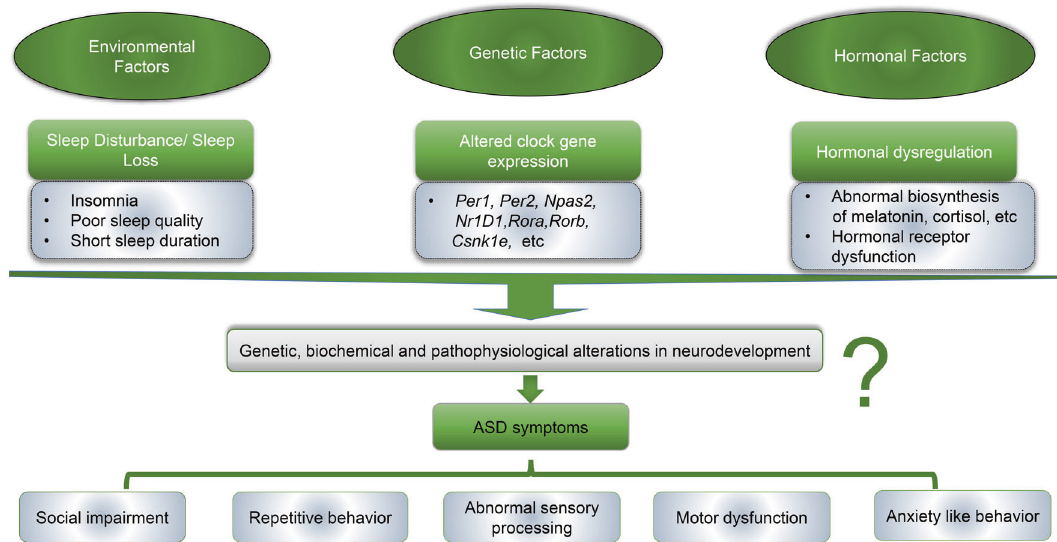
Fig. 4 A hypothetical model whereby circadian and sleep dysfunctions might contribute to the pathogenesis of autism spectrum disorders. The environmental, genetic and hormonal risk factors cause sleep and circadian disturbances, which may in turn lead to impairments in neurodevelopment and cause neurodevelopmental disorders such as